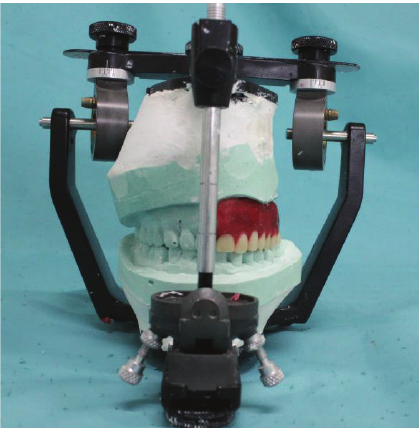
Figure 5: Adaptation of baseplate wax in the defect with stoppers for relief.